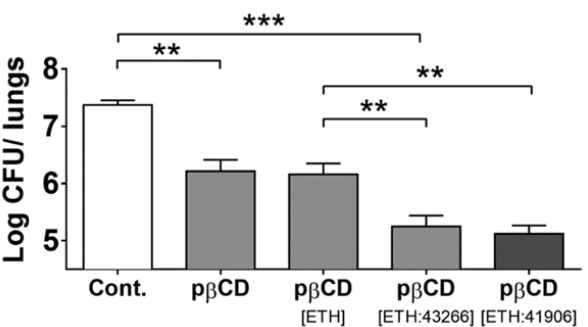
Figure 13. Effect of the administration of β -cyclodextrin-based nanoparticles (p β CD) loaded with ethionamide (ETH) on the bacterial load in the lungs of Mycobacterium tuberculosis -infected mice. The different conditions (control group, empty p β CD, ETH-loaded p β CD and ETH- and booster- loaded p β CD (BDM43266 or BDM41906)) are compared. Bacterial count was performed after the endotracheal administration of 6 doses of 7.5 mg of nanoparticles. Symbols ** and *** denote p < 0.01 and p < 0.001, respectively. Reference [131], used under the standard ACS Author’s Choice/Editor’s Choice Usage Agreement.